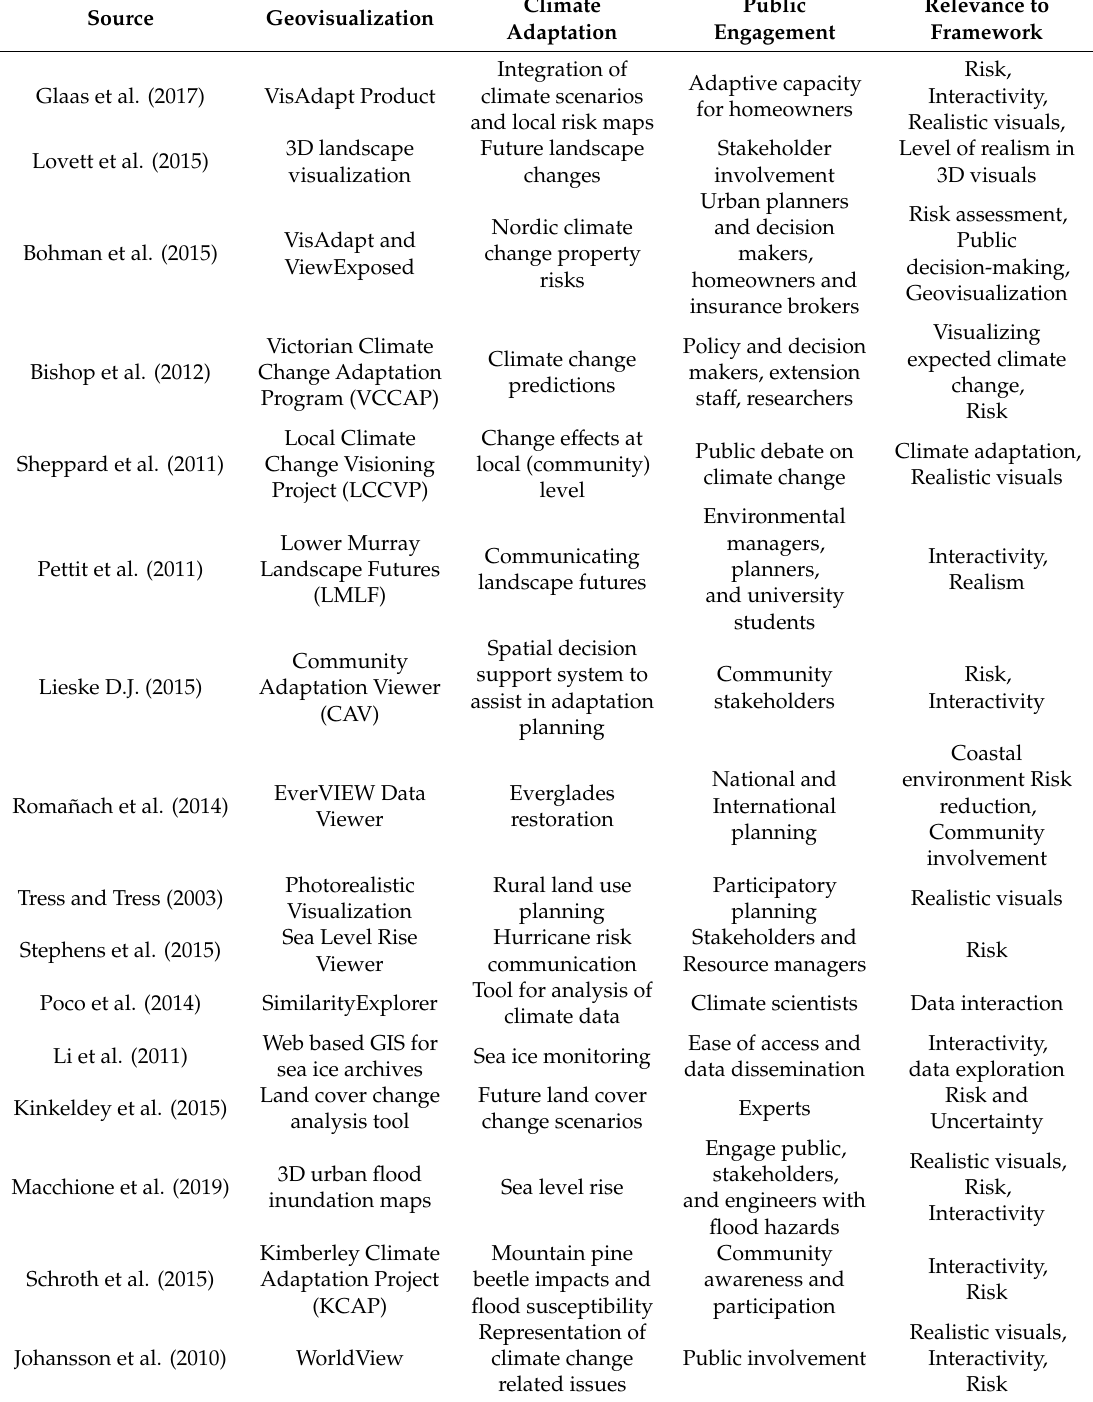
Table 2. Research used to test and refine the CVAP